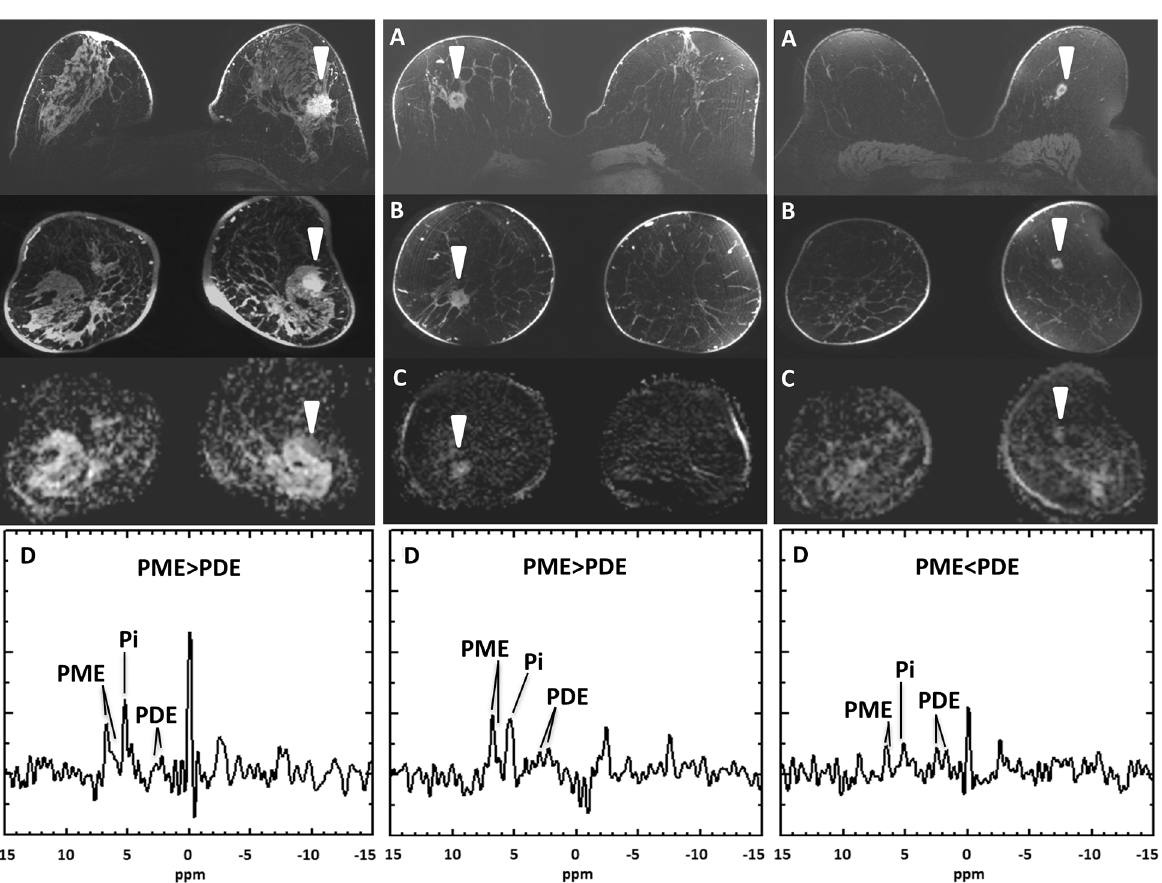
Fig 2. Examples of 7 tesla MR imaging in three patients, showing the first post-contrast dynamic contrast-enhanced MR imaging in the (A) transverseplane and the (B) coronal plane, with (C) the corresponding apparent diffusion coefficient (ADC) map; and (D) the corresponding 31-phosphorus MR spectroscopy ( 31 P-MRS) scoring upon the ratio of phosphomonoesters (PME) to phosphodiesters (PDE). All three patients (left/middle/right) had a negative preoperative indicationfor systemic therapy basedon biopsy and conventional breast imaging.On the left, imagingis shown of a 47-year old woman. The decision-treemodel upstagesthis assessment to positive indication:DCE-MRI showeda 23-mm sized lesion,an ADC of 746 x10 − 6 mm 2 /s, and a PME > PDE score. Postoperatively, a grade 2 tumor and a positive indicationfor systemic therapy was established. In the middle,imagingis shown of a 58-year old women. The decision-tree model again upstagesthis assessment to positive indication:DCE-MRI showedan 18-mm sized lesion, an ADC of 980 x10 − 6 mm 2 /s. The MRS score was, however,PME > PDE. Postoperatively, a grade 2 tumor and a positive indication for systemic therapy was established. On the right, imagingis shownof a 71-year old woman. The decision-tree model confirms the negativeindication:DCE-MRI showed a 16-mm sized lesion,DWI a mean ADC of 834 x10 − 6 mm 2 /s, and 31 P-MRS a PME < PDE score. Postoperatively, a grade2tumor and a negativeindicationfor systemic therapy was established. Pi = Inorganicphosphate.